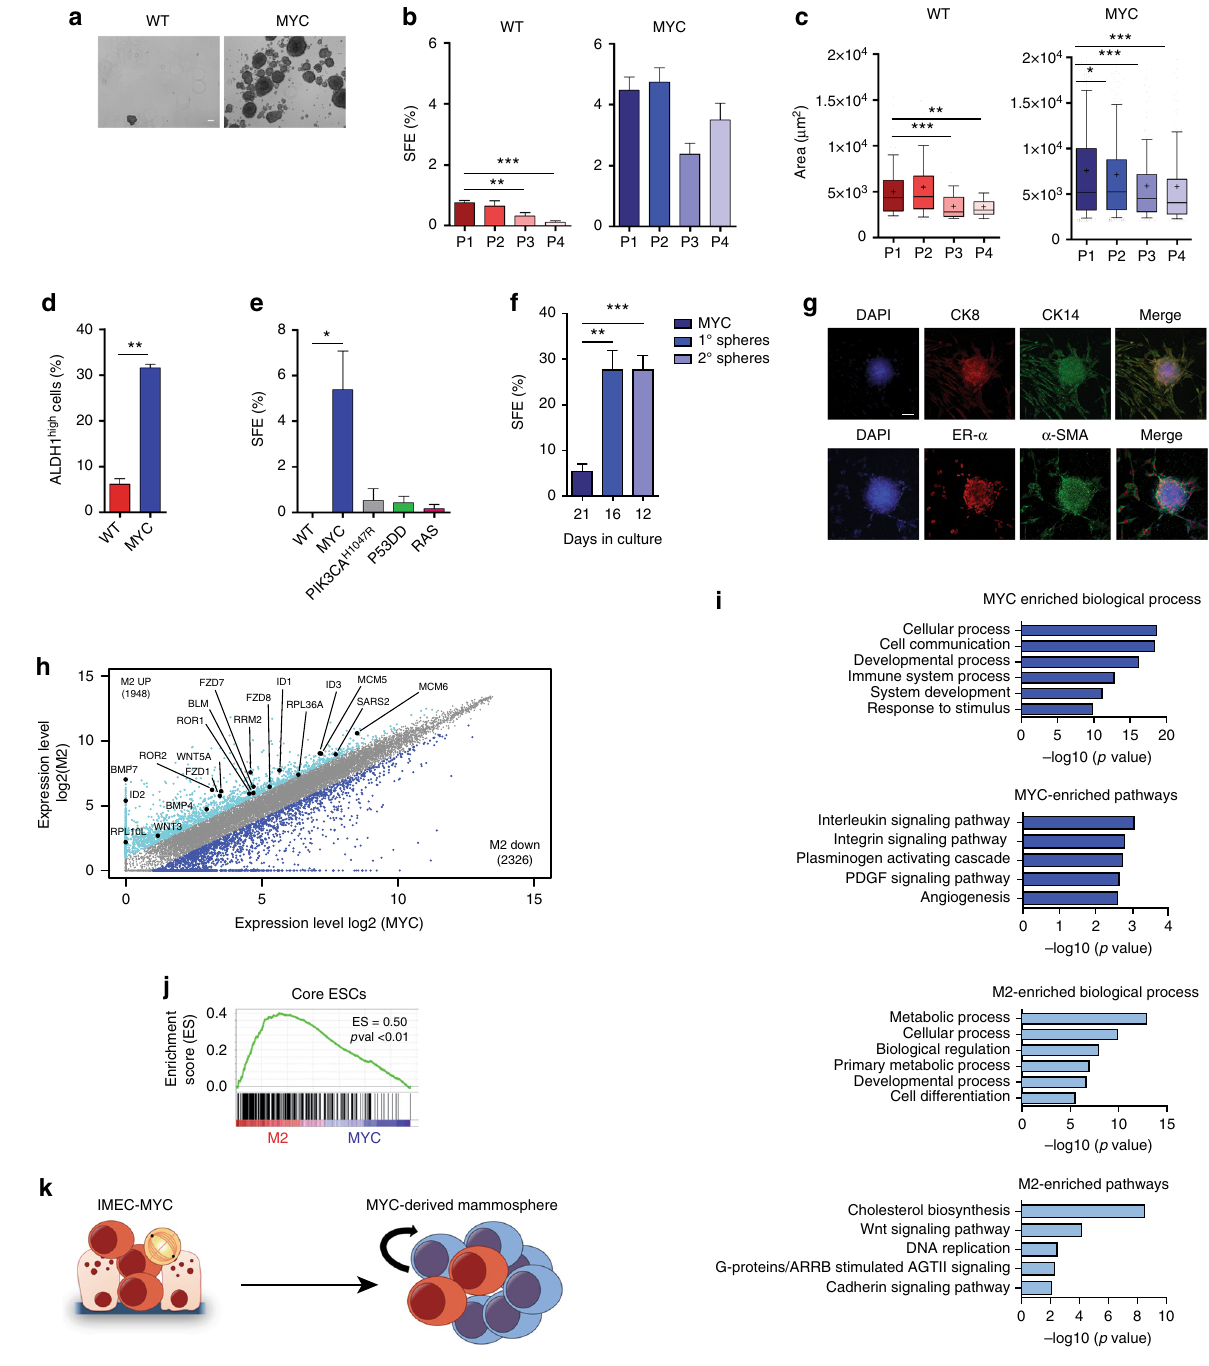
Fig. 2 Sustained MYC overexpression confers stem cell-like traits. a Phase contrast images of IMEC WT and IMEC-MYC cultured in low adhesion conditions. Scale bar, 100 µ m. b Spheres formation ef fi ciency (SFE) of IMEC WT and IMEC-MYC at indicated passages ( n = 6) (** P < 0.01, *** P < 0.001; Student ’ s t- test). c Area ( μ m 2 ) of mammospheres formed by IMEC WT and IMEC-MYC at indicated passages ( n = 6). Whiskers extend to 10th and 90th percentiles; central horizontal bar and black cross indicate median and mean, respectively (* P < 0.05, ** P < 0.01, *** P < 0.001; Student ’ s t- test). d Percentage of ALDH1-positive cells in IMEC WT and IMEC-MYC cultured in low adhesion conditions. Data are means ± SEM ( n = 3) (** P < 0.01; Student ’ s t- test). e Single cell SFE of IMEC WT, -MYC, -PIK3CA H1047R , -P53DD and -RAS. Data are means ± SEM ( n = 3) (* P < 0.05; Student ’ s t- test). f Serial single-cell SFE of IMEC-MYC, IMEC-MYC-derived 1° Spheres (M1) and IMEC-MYC-derived 2° Spheres (M2). Single-cell-derived clones were obtained at the indicated time. Data are means ± SEM ( n = 4) (** P < 0.01, *** P < 0.001; Student ’ s t- test). g Immuno fl uorescence for basal (CK14 and α -SMA) and luminal (CK8 and ER- α ) markers on differentiated M2. Scale bar, 50 µ m. h Scatter-plot of gene expression pro fi le of IMEC-MYC and M2. Genes up- (cyano) and downregulated (blue) in M2 with respect to IMEC-MYC are highlighted. Relevant M2 upregulated genes are indicated ( n = 3). i GO analysis of differentially regulated genes between IMEC-MYC and M2 ( n = 3). j GSEA of the core embryonic stem cell (ESCs) gene module in IMEC-MYC vs. M2 ( n = 3). k Scheme representing IMEC-MYC and IMEC-MYC-derived mammospheres, enriched for cells with self-renewing